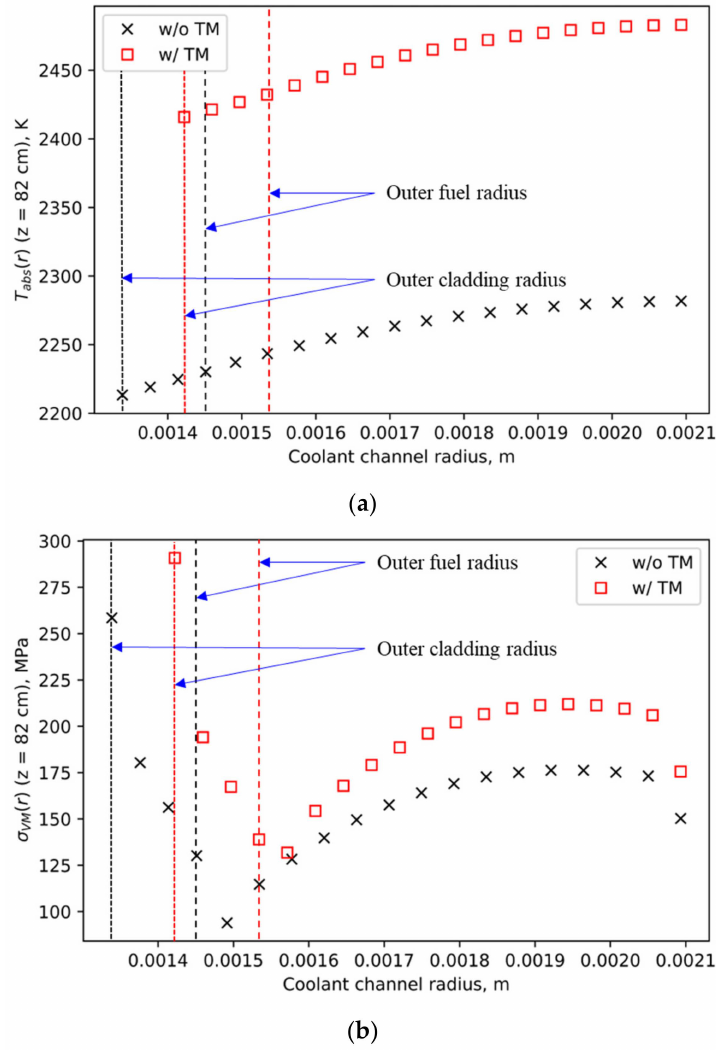
Figure 17. Comparison of radial ( a ) temperature; ( b ) von Mises stress; profile for maximum von Mises stress location in a single flow channel surrounded by fuel.